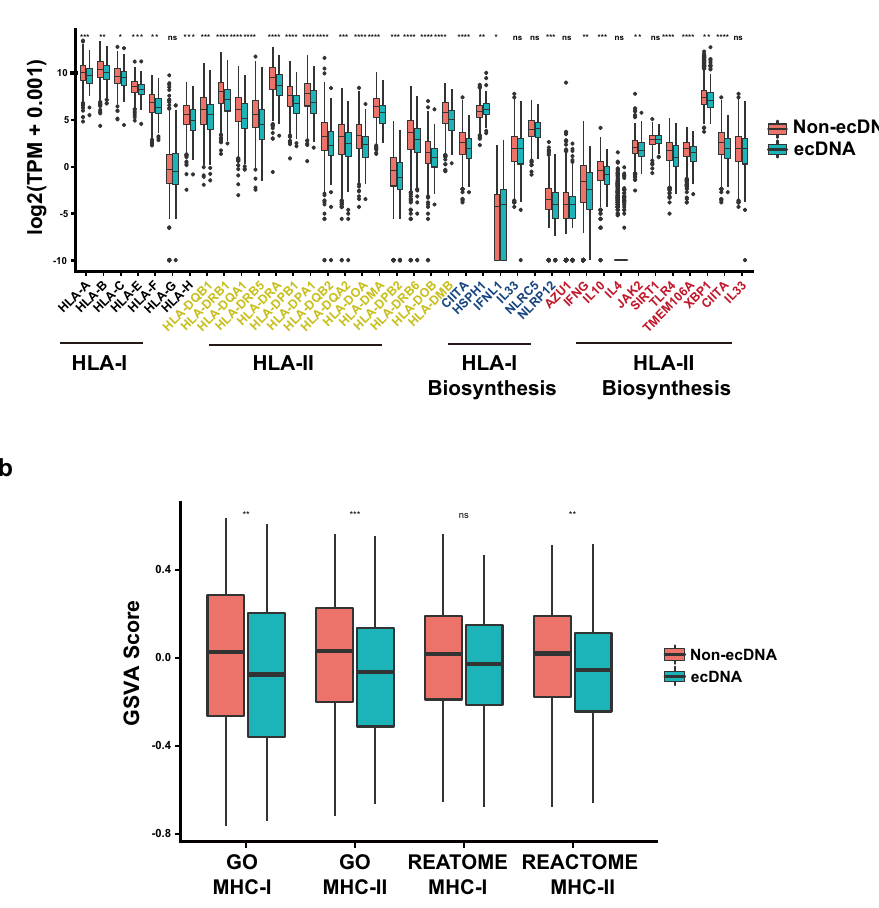
Figure 5. ecDNA and antigen presentation genes’ expression. ( a ) mRNA expression of MHC class I and class II antigen presentation related genes in tumors with and without ecDNA. Wilcoxon test P values are shown. ( b ) GSVA scores of MHC class I or class II antigen presentation genes in tumors with and without ecDNA. Wilcoxon test P values are shown. ns: P > 0.05, *: P ≤ 0.05, **: P ≤ 0.01, ***: P ≤ 0.001, ****: P ≤